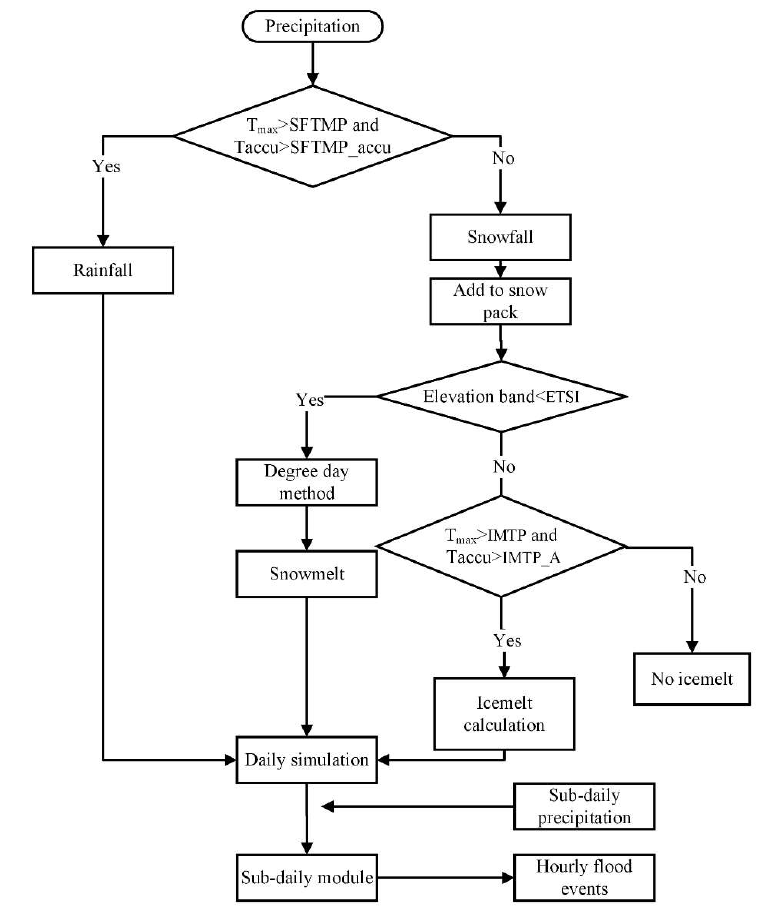
Figure 2. Methodological roadmap for this study. 159